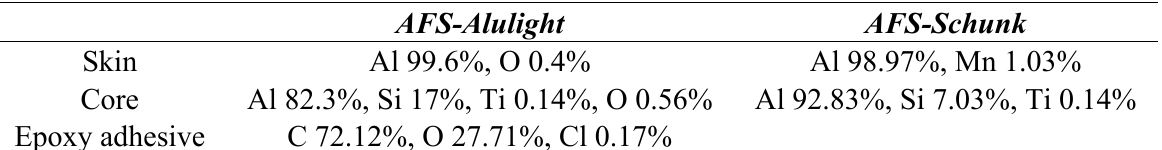
Table 1. Chemical composition of the AFS panels.